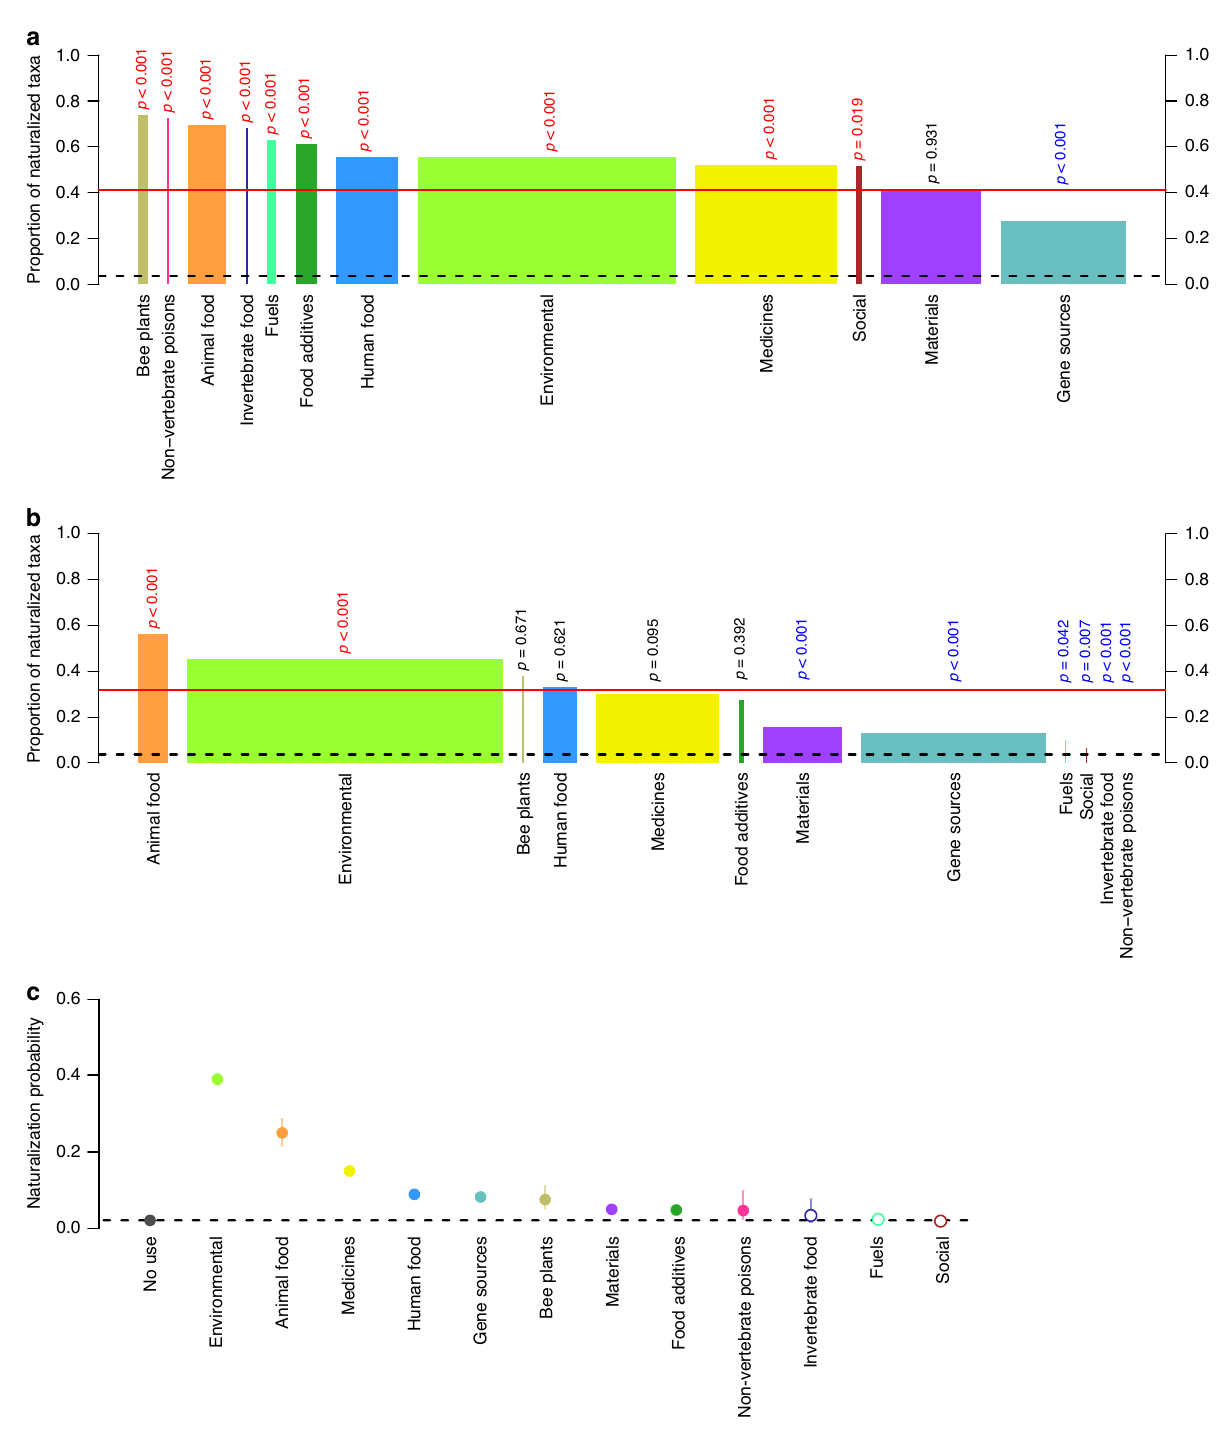
Fig. 2 The proportion of naturalized taxa within each economic use category. Spineplots for ( a ) all taxa in the WEP dataset ( n = 11,685), and ( b ) the subset of taxa with a single economic use ( n = 8246), and ( c ) naturalization probabilities estimated with a phylogenetic GLM on all seed plants ( n = 326,101). In ( a , b ), the width of each bar is proportional to the number of taxa. The economic use categories are ranked according to ( a , b ) the proportion of naturalized taxa or ( c ) naturalization probability. As reference proportions, the red solid lines indicate the proportions of naturalized taxa in ( a ) the full WEP dataset and ( b ) the single-use subset, respectively. The black dashed line indicates ( a , b ) the proportion of naturalized taxa in the extant global seed plant fl ora (economic and noneconomic plants combined) or ( c ) the naturalization probability of taxa without economic use. In ( a , b ), p values from two-sided resampling tests indicate whether the proportion of naturalized taxa is signi fi cantly higher (red) or lower (blue) than expected or does not deviate from expectations (black). In ( c ), the error bars indicate 95% con fi dence intervals, and fi lled circles indicate economic uses where the naturalization probability differs signi fi cantly from taxa with no economic uses ( p < 0.05; for exact p values see Supplementary Table 1). No corrections were made for multiple comparisons. Supplementary Fig. 11 shows spineplots for the subcategories within each economic use